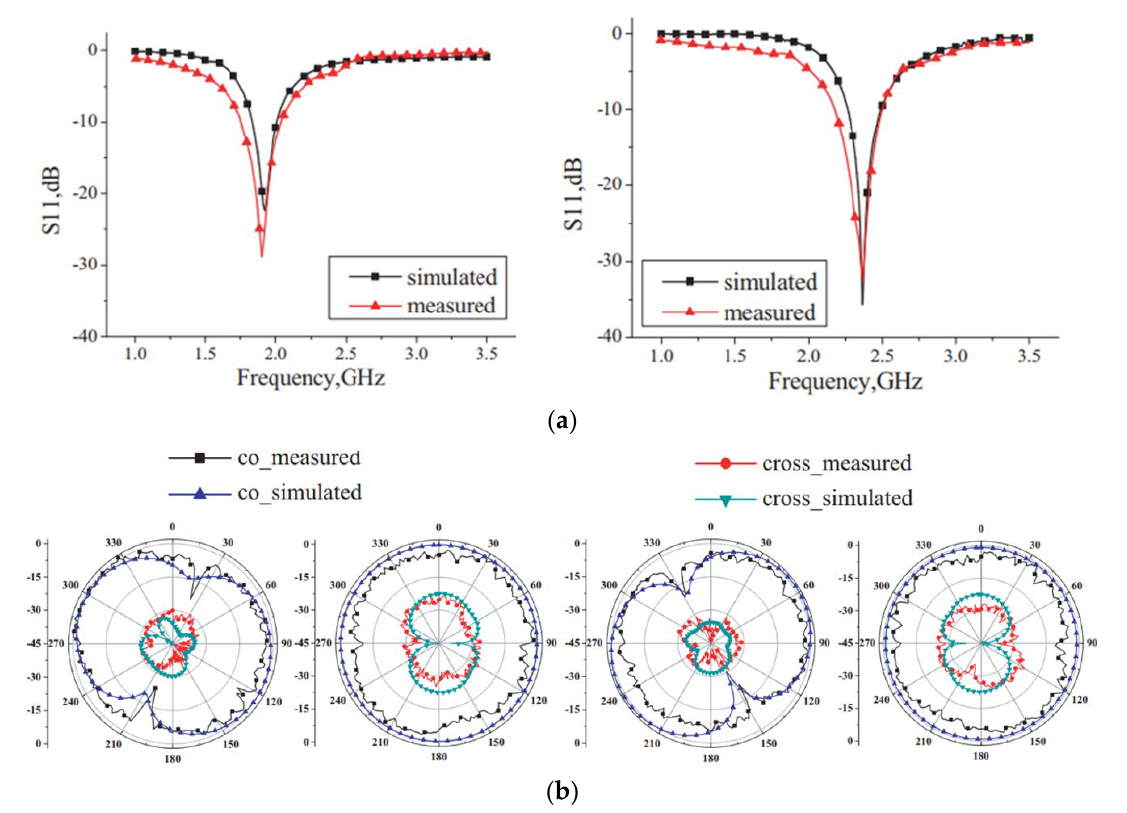
Figure 12. ( a ) Comparison among simulated and measured S-parameters; ( b ) radiation pattern for resonating frequencies. Reprinted from Ref. [105].